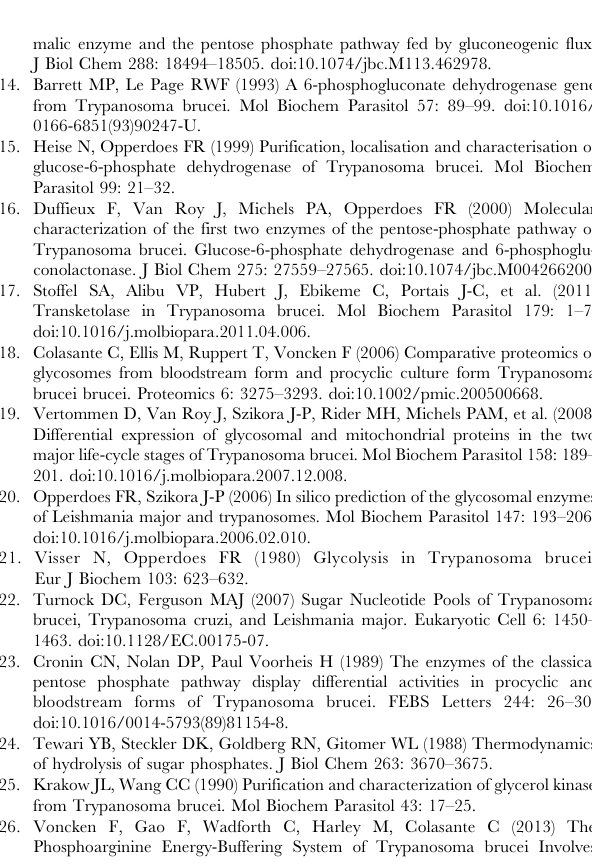
Table S2 Elementary flux modes in models of PPP. The elementary modes of different model versions including the glycosomal PPP are listed as the overall reactions plus in brackets the individual enzyme-catalyzed reactions with their relative flux weight. For simplicity the cytosolic PPP and the cytosolic NADPH utilization were left out of this analysis. The modules included in each model version refer to Table 1 and the color-coded extensions in Figure 1 in the main text. A negative number indicates that the reaction occurs in the reverse direction as compared to Table 1 in the main text. The order of reactions corresponds to that in Table 1 in the main text. The glycolytic modes 1–3 are possible in all model versions, but are not listed again for the model versions extended with the glycosomal PPP. Elementary mode analysis of model B only results in the flux modes 1–3. Table S3 Predicted glycosomal proteome. All reactions present in the bloodstream form T. brucei glycosome, according to comprehensible glycosomal proteomics [18,19]. Only reactions present in the bloodstream form of the parasite are included. Abbreviations and EC numbers are given for each reaction. Models are indicated where reactions are part of a model in the main text. Indicated are what reactions are part of an elementary model (see Table S4). Table S4 Elementary modes in glycosomal proteome. A model of glycosomal metabolism was constructed for use in METATOOL version 4.9.3 [60]. The reactions from Table S3 were used. All reactions were set as reversible, except